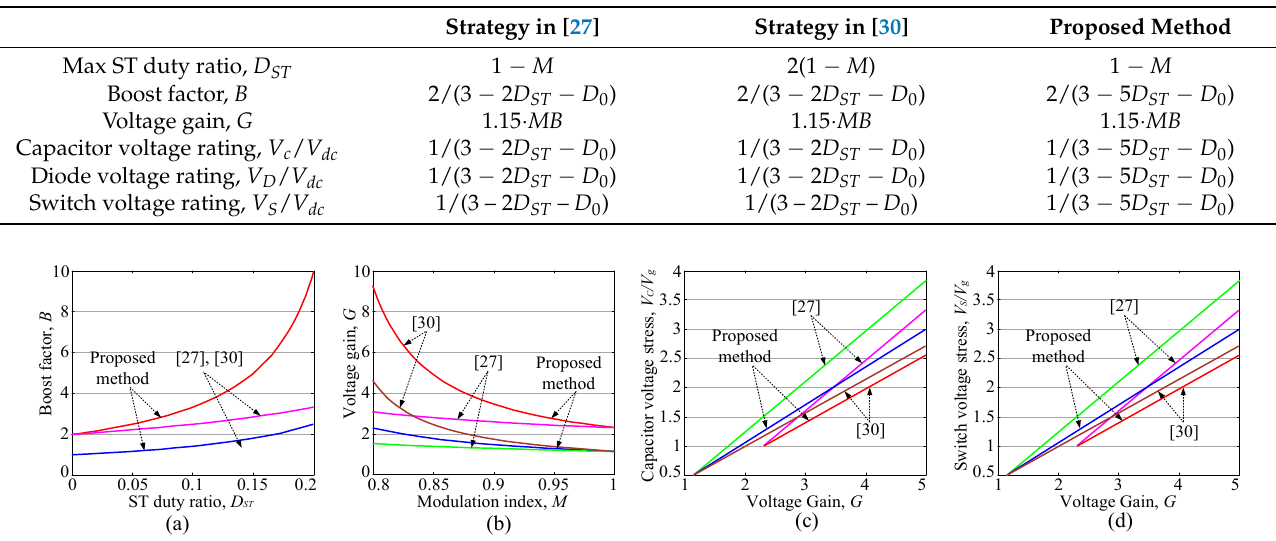
Figure 7. ( a ) The ST duty ratio vs boost factor, ( b ) modulation index vs voltage gain, ( c ) voltage gain vs capacitor voltage rating, and ( d ) voltage gain vs switch voltage rating.